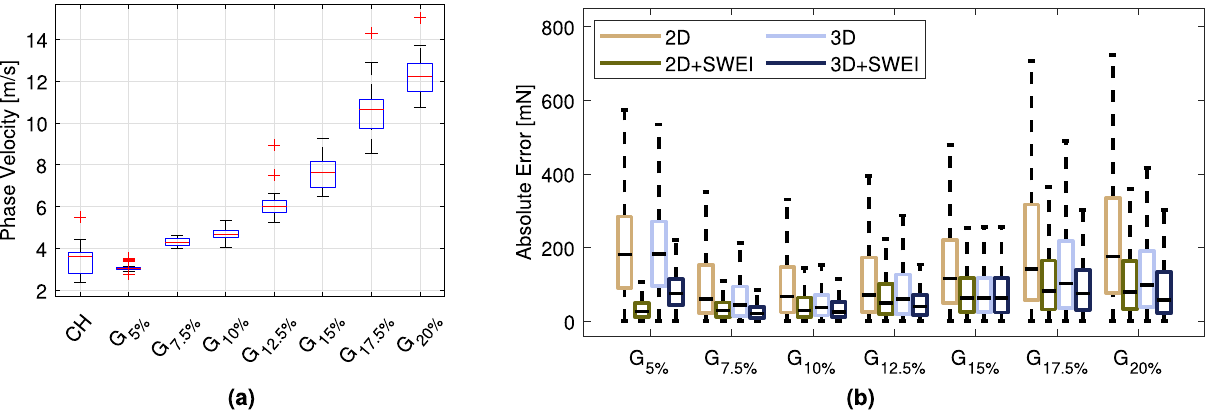
Figure 6. (a) Estimated phase velocities in gelatin phantoms and chicken heart (CH) soft tissue. (b) Absolute error of the force estimation models generalizing to each sample elasticity. Model performance is compared between 2D and 3D inputs as well as with and without SWEI fusion. Outliers are omitted and colors follow scientifically derived recommendations. 45